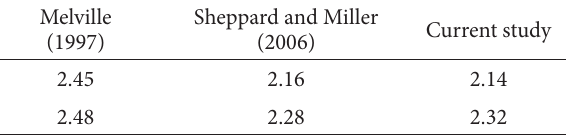
Table 3. Characteristics of experiments regarding bridge pier model scour in one-sided collar Q , lits -1